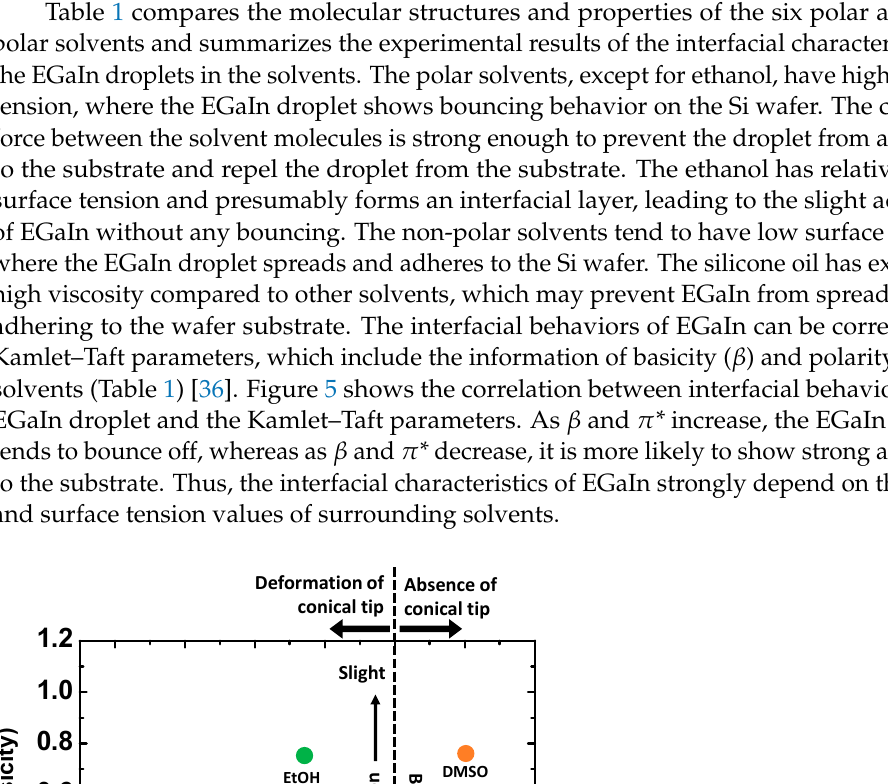
adhesion, but sitting with a high surface tension.